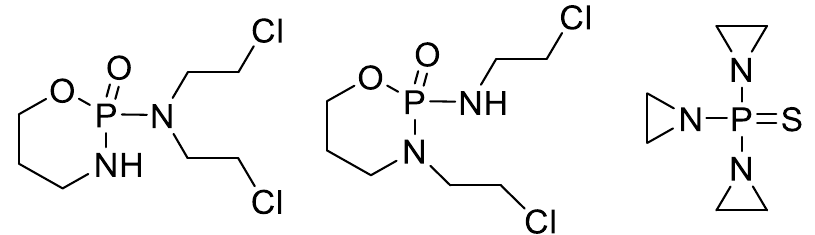
Figure 1. Cyclophosphamide (left), ifosfamide (midde), thiotepa